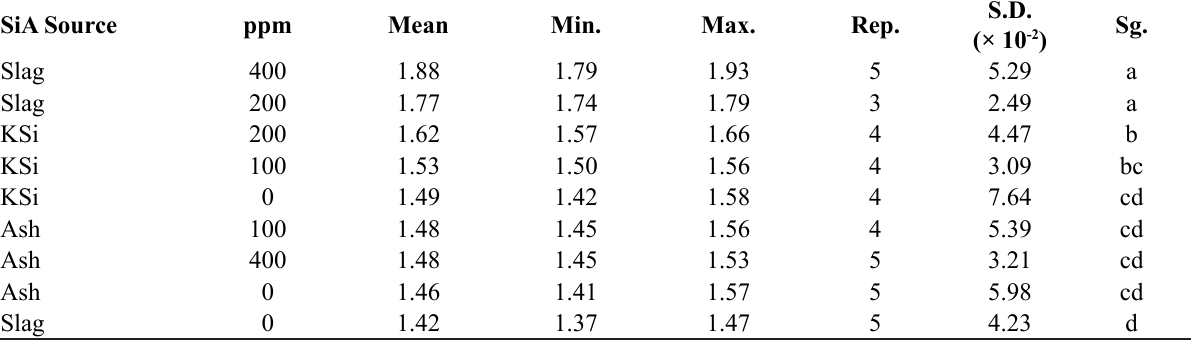
Table 6. Statistical summary of available silicon-SiA (ppm) data at the end of the campaign, transformed with . Significance levels were obtained with Tukey test, α =